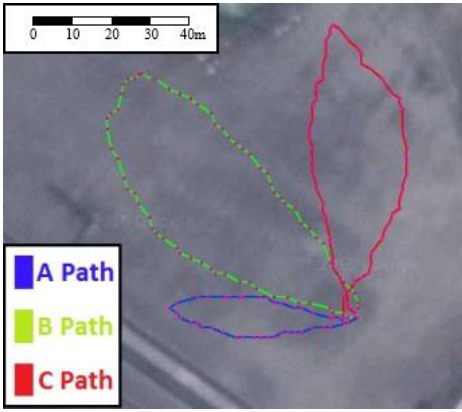
Figure 12. Experimental Trajectory When the Maximum Distance Limit Is 170 m.